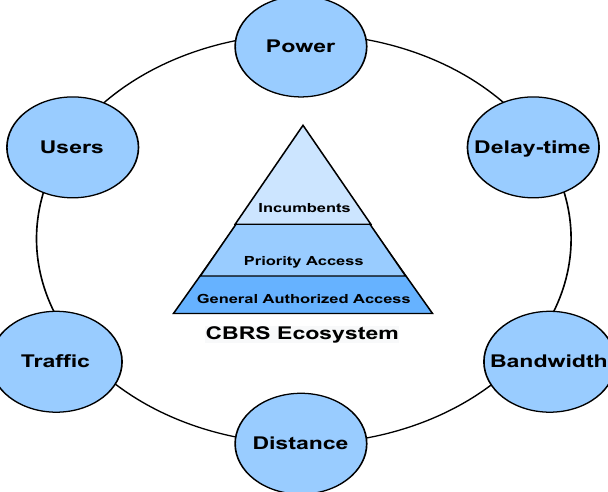
Figure 5. Resource allocation parameters of a spectrum in CBRS